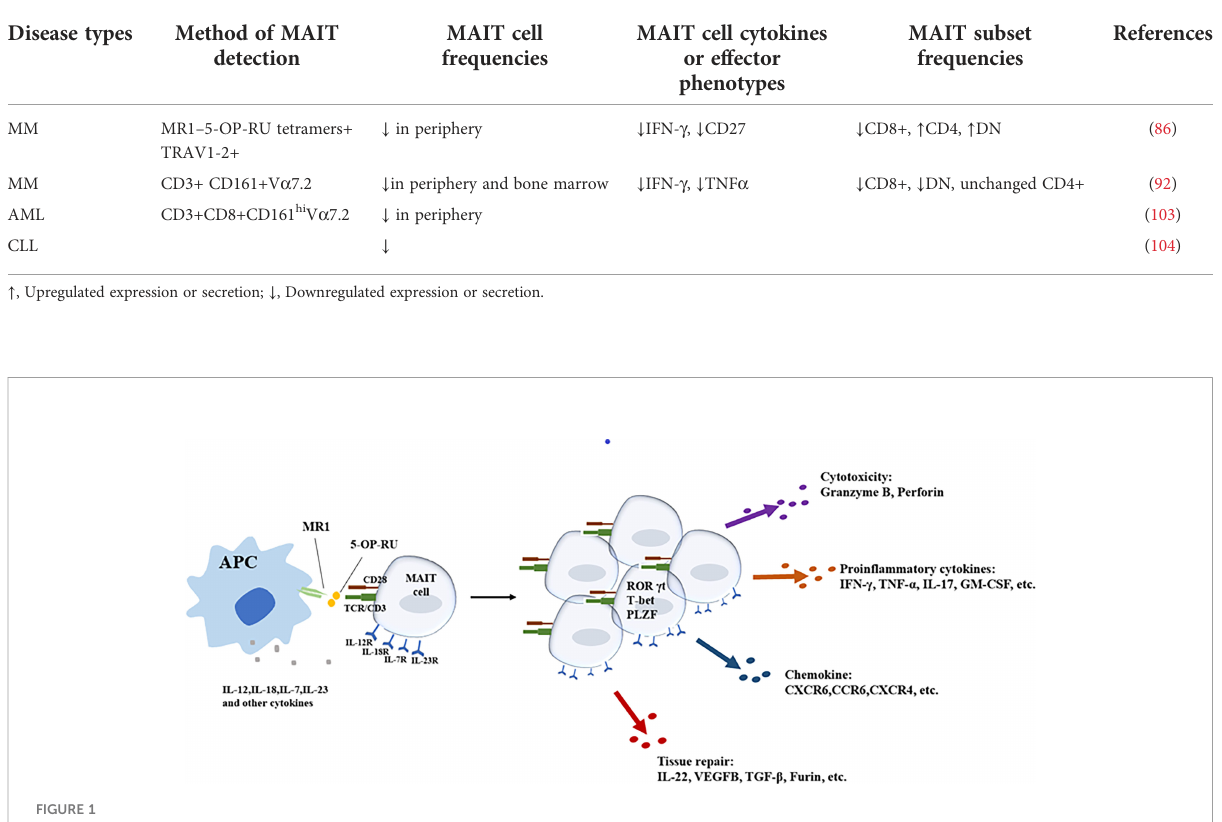
TABLE 3 Summary of research in hematological malignancies.